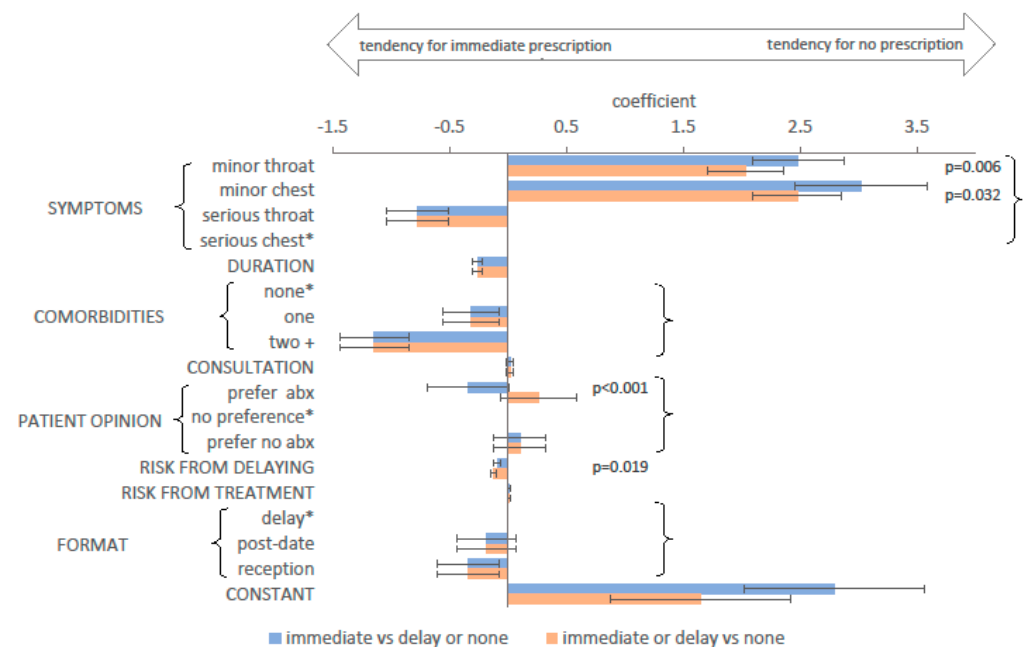
Figure 3. Coe ffi cients for the ordered logistic regression model. Symptoms descriptions: minor throat—sore throat and swollen glands; minor chest—chesty cough and runny nose; serious throat—sore throat, swollen glands and fever; serious chest—chesty cough, fever and pain on breathing. * Reference level for categorical variables. p -values are shown where the coe ffi cients di ff ered ( p < 0.05) between the choice to give an immediate prescription, and the choice to prescribe at all. For all other attributes and levels, the p -value for this di ff erence was greater than 0.05, and the coe ffi cients were constrained to be equal in the model. Bars indicate 95% confidence intervals. Abbreviations: abx—antibiotics.